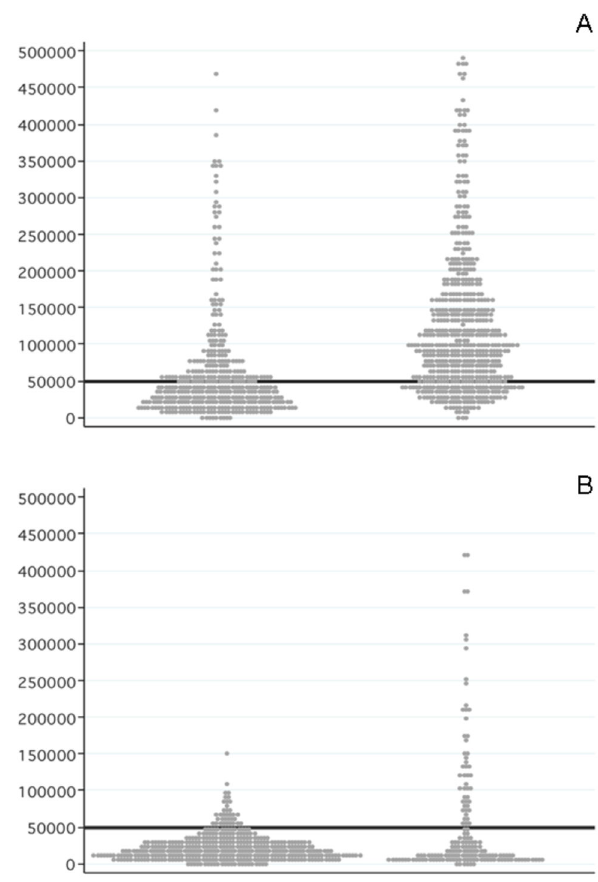
Figure 2. Variations in cost-effectiveness results by funding source and prevention category: a) Primary CV prevention and b) Secondary CV prevention.